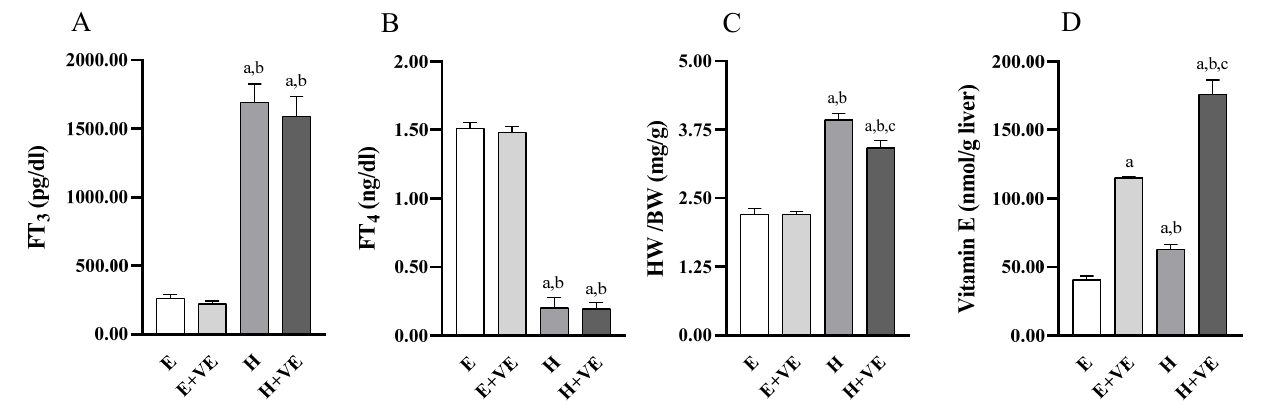
Figure 1. Body parameters. FT 3 plasma levels ( A ), FT 4 plasma levels ( B ), heart weight/body weight ratio ( C ), and Vitamin E content in liver tissue ( D ). Values are means ± SEM of eight determinations from different rats. Each determination is the mean of three independent measures for the data reported in panels A, B and D. E, euthyroid; E + VE, euthyroid fed vitamin E supplemented diet; H, hyperthyroid; H + VE, hyperthyroid fed vitamin E supplemented diet. a significant vs. E. b significant vs. E + VE. c significant vs. H. The level of significance was chosen as p < 0.05. The vitamin E content (Figure 1D) was increased by both thyroid hormone treatment and Vitamin E supplementation so that in the H + VE animals, the vitamin E content was the